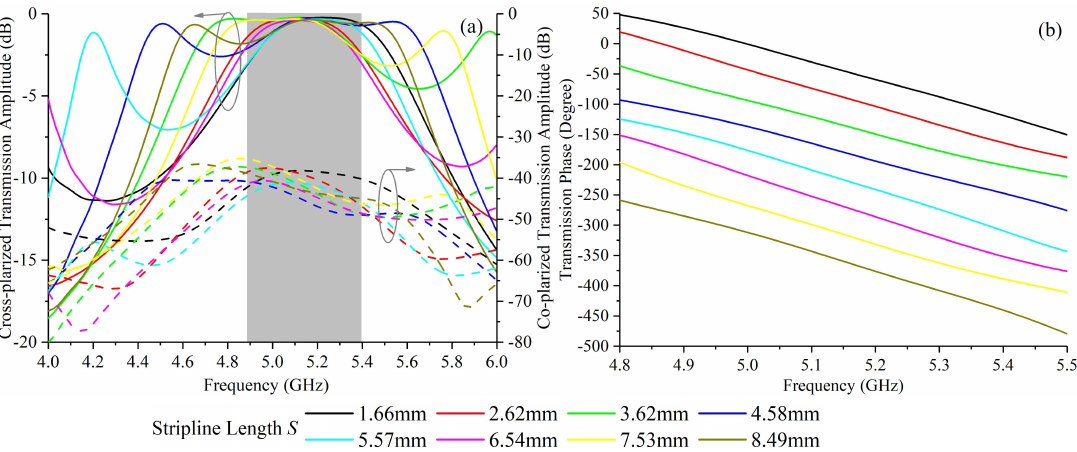
Figure 4. The simulated transmittance of the unit cell with different stripline lengths S (as in Figure 2c): ( a ) Amplitude. ( b ) Phase.